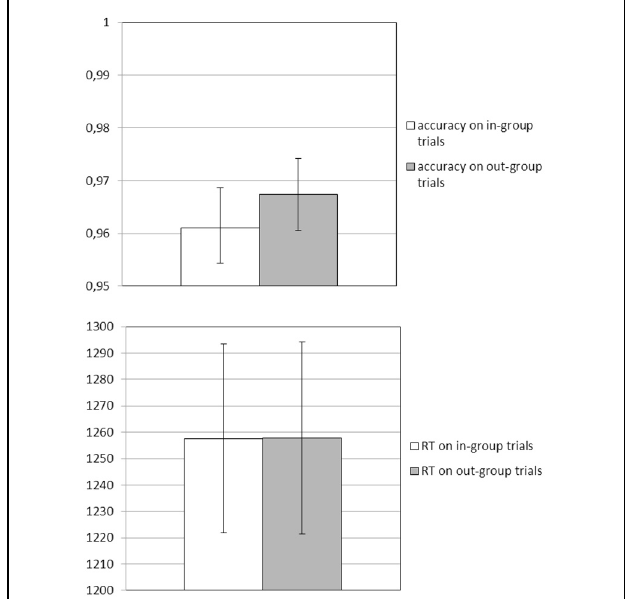
FIGURE 3 | Behavioral responses in the scanner: mean accuracy (top panel) and response times (RT; lower panel) while participants categorized in-group and out-group